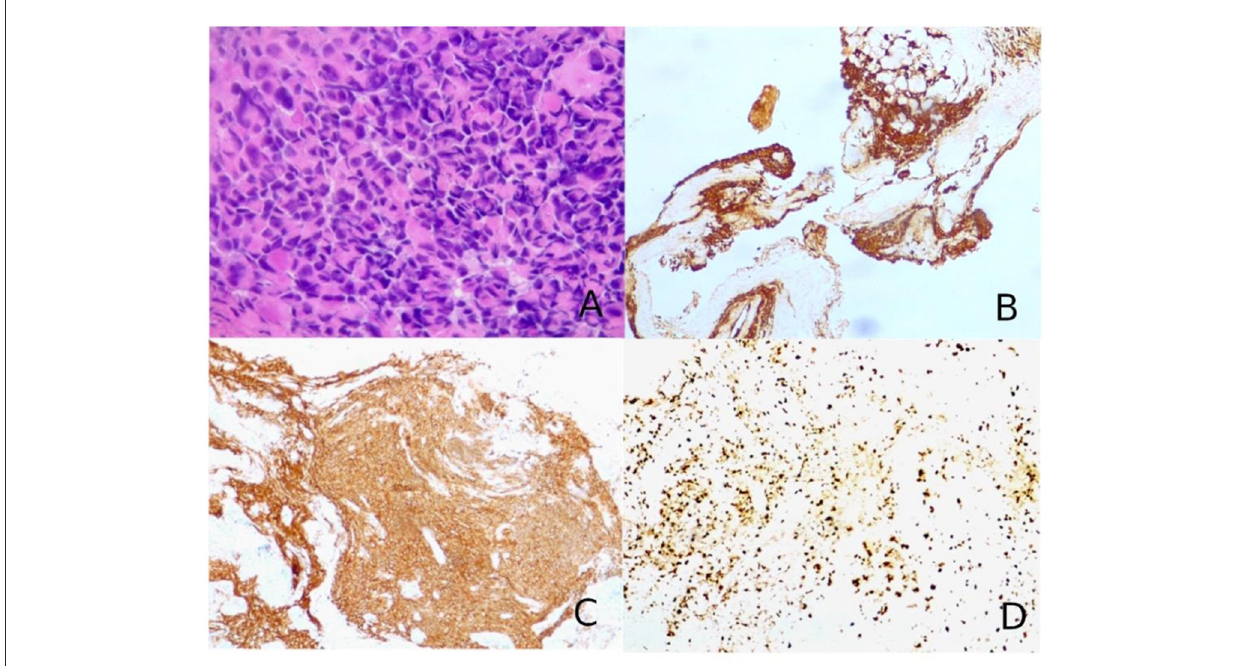
FIGURE3 (A) Hematoxylin–eosin slides showed a hypercellular tumor composed of large, epithelioid, often nucleolated cells, with abundant cytoplasm, arranged in a “vertebral-like” fashion ( hematoxylin–eosin, original magnification 40x ). (B) Tumor cells were positive for pancytokeratin (AE1/AE3; immunoperoxidase staining, original magnification 10x ). (C) Neuroendocrine markers were consistently positive, as for synaptophysin shown in the figure ( immunoperoxidase staining, original magnification 10x ). (D) The cellular proliferation index Ki67 was nearly 70–80% ( immunoperoxidase staining, original magnification 10x